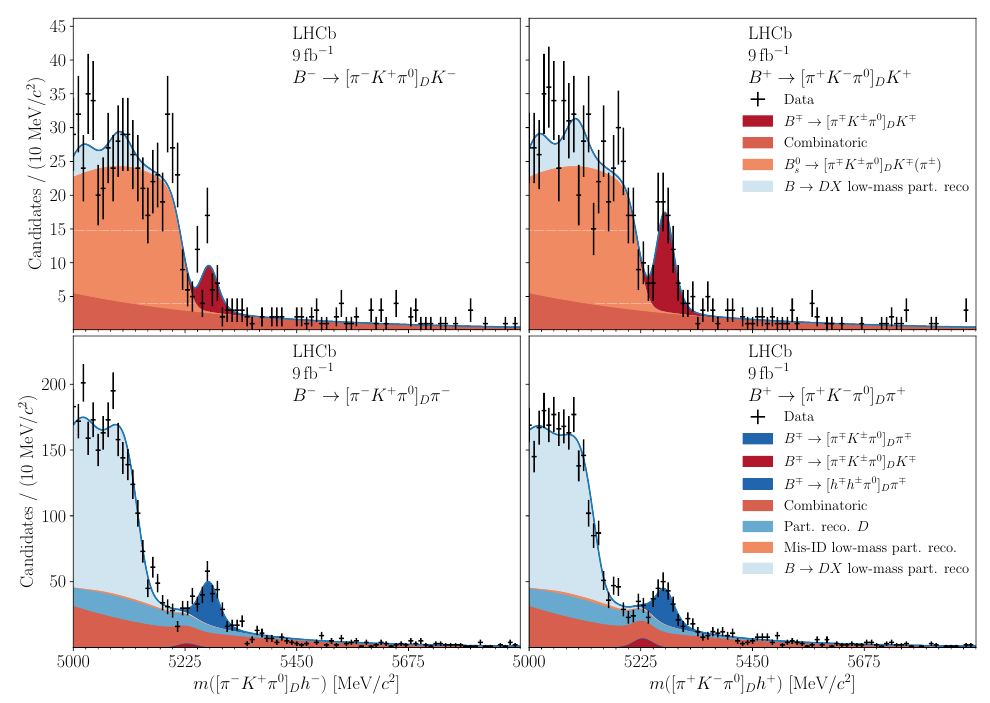
Figure 2 . Mass distributions of B ∓ → [ π ∓ K ± π 0 ] D K ∓ (top) and B ∓ → [ π ∓ K ± π 0 ] D π ∓ (bottom) candidates, separated by